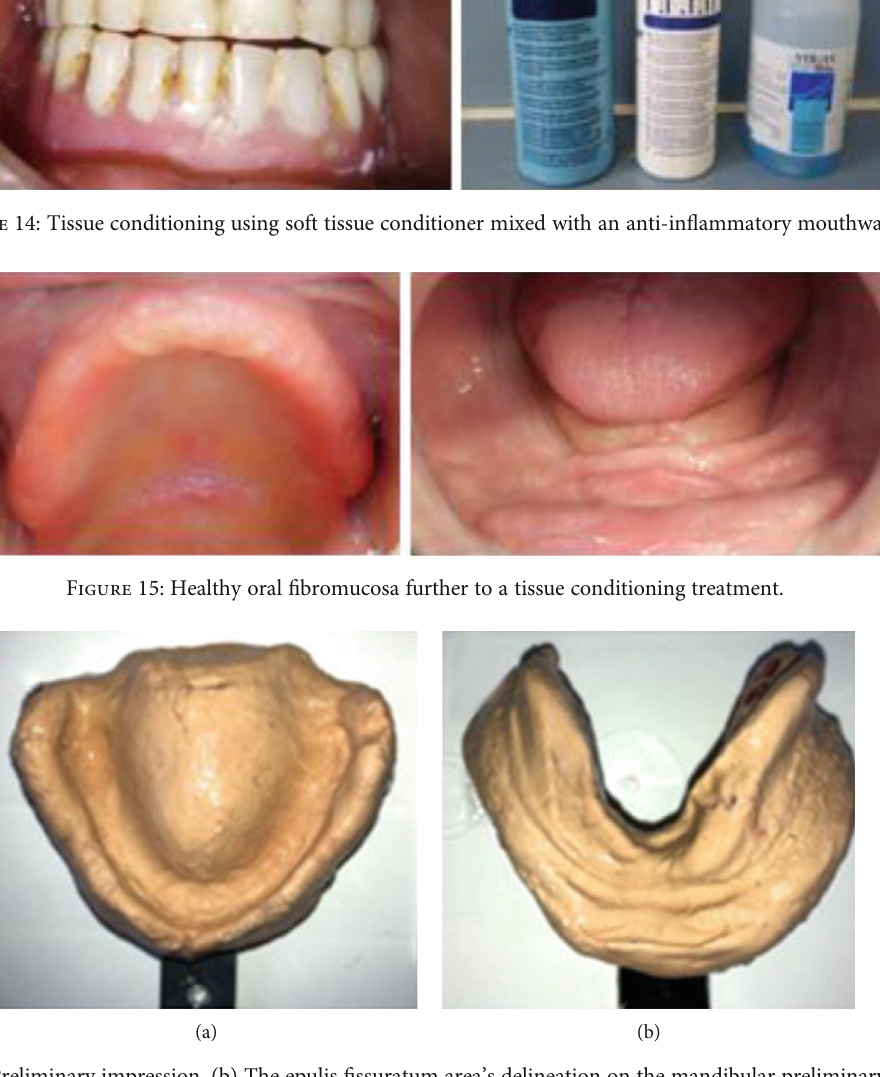
Figure 16: (a) Preliminary impression. (b) The epulis fi ssuratum area ’ s delineation on the mandibular preliminary impression.